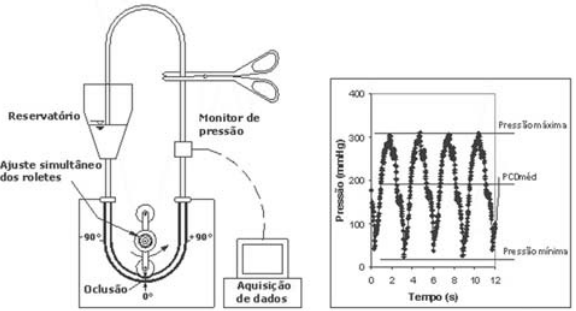
Fig. 2 – Ilustração da configuração usada para calibração dinâmica (esquerda). Curva dos registros de pressão pelo tempo (direita), por conveniência mostrada apenas com intervalo de 12